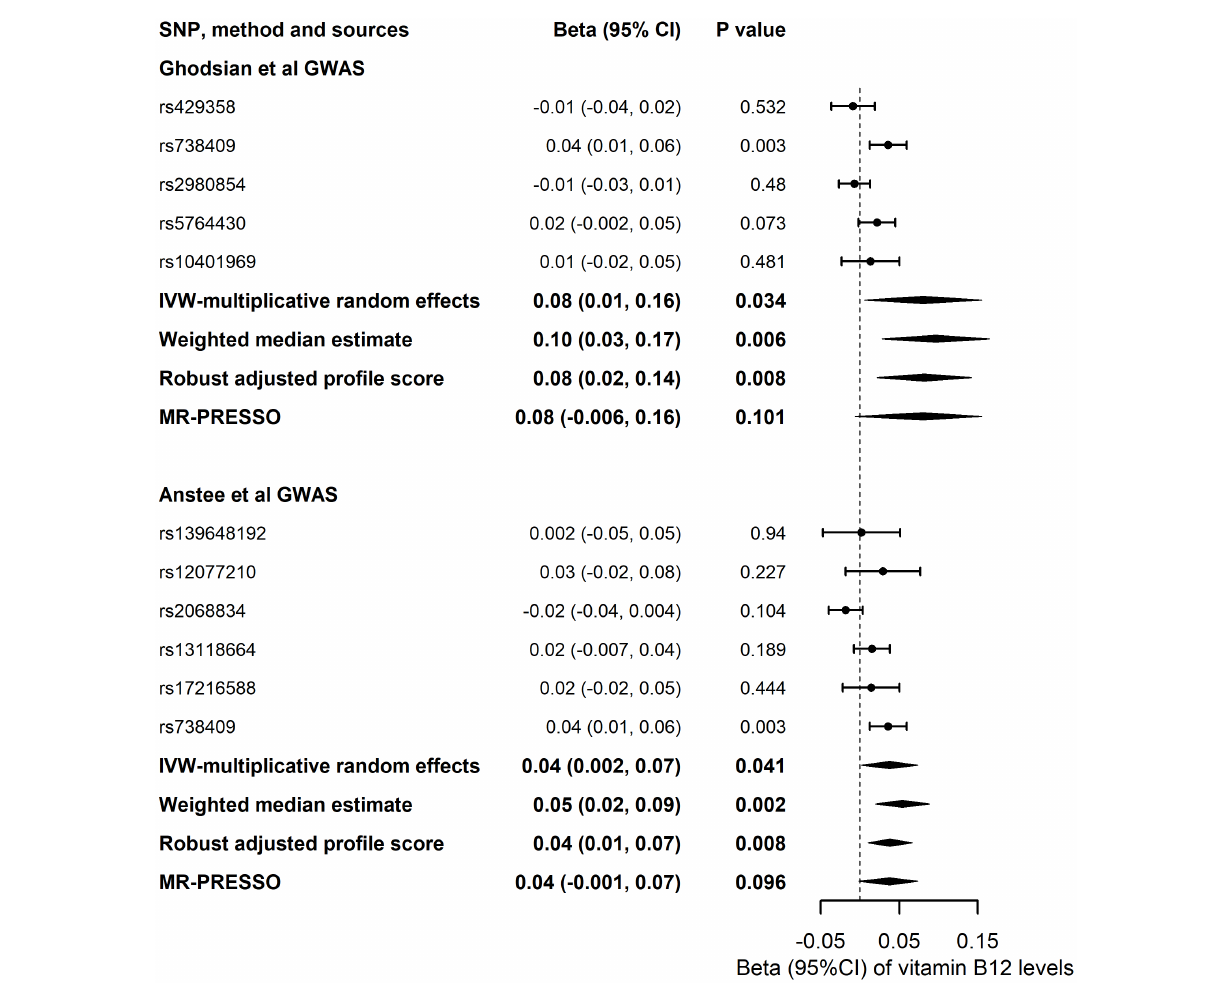
FIGURE 3 Association of genetic liability to NAFLD with Vitamin B12. Vitamin B12, serum Vitamin B12; IVW, inverse variance weighted; MR-PRESSO, Mendelian randomization pleiotropy residual sum and